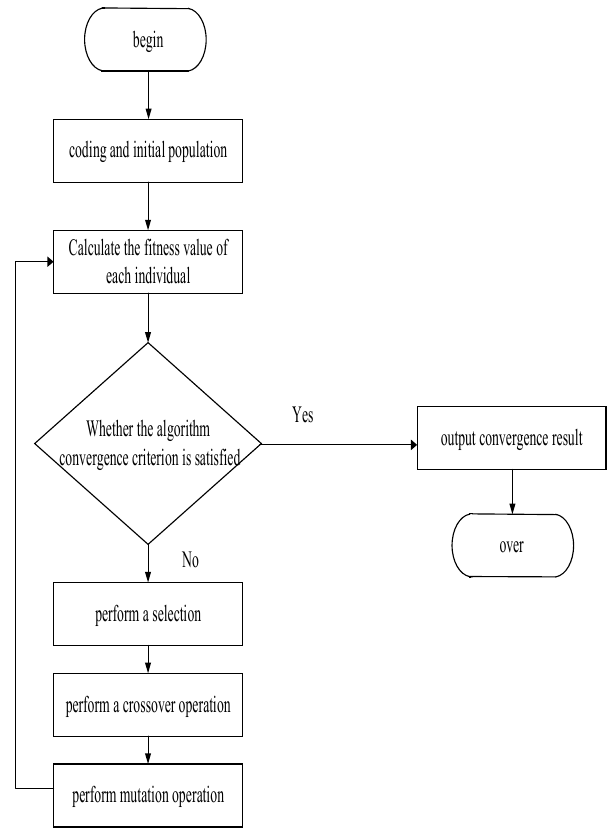
Figure 10. Flowchart of the genetic algorithm.